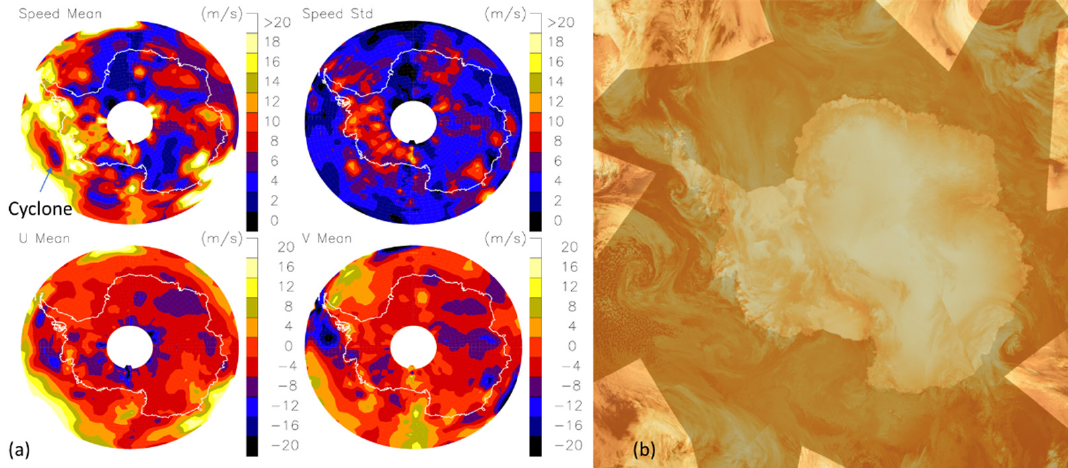
Figure 16. Low-level (500–2000 m) stereo-wind statistics from 7 to 11 July 2021 for mean and standard deviation of wind speed; mean U and V components are shown at the left ( a ). The right panel ( b ) is a Terra/MODIS cloud mosaic (from the visible and IR bands) on July 9 when a cyclone was evident in the western Antarctic (see text for more information).